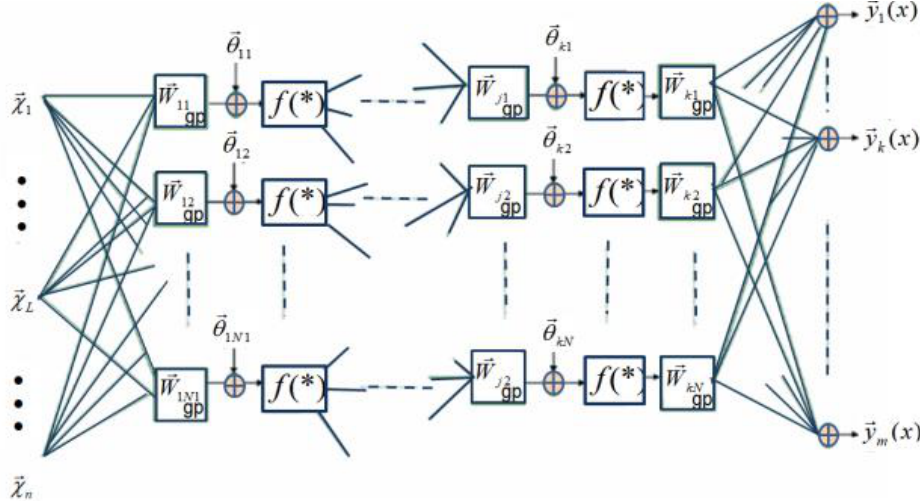
Figure 6. A simplification of the learning rule discussed in Ref. [57], where it is suggested that in the training of geometric feedforward networks, the weights of the output layer could be real values (the output weight multivectors could be scalars of k